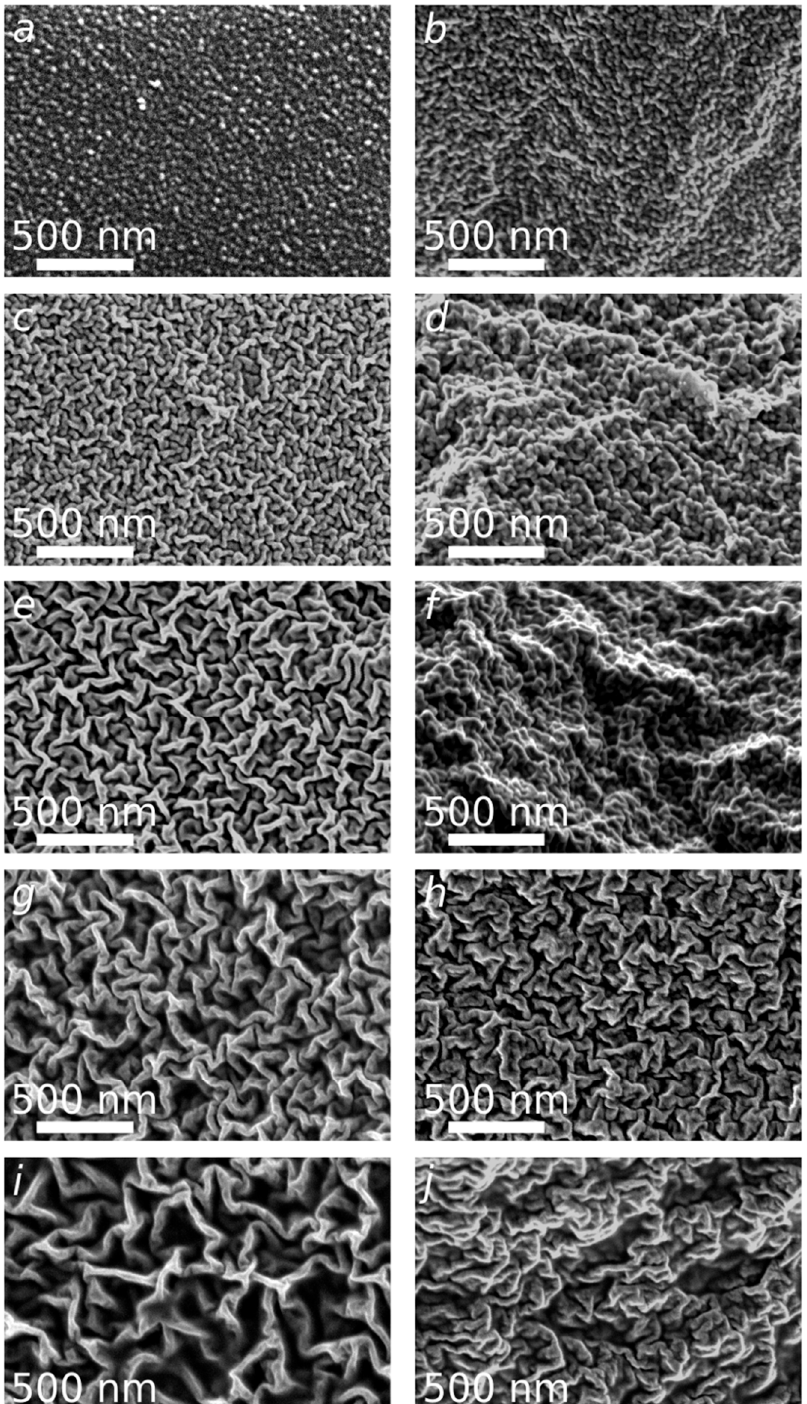
Figure 3. SEM micrographs of the reference CS film (CS/DES-0) ( a , b ) and films with different NADES contents: 50 wt% ( c , d ), 67 wt% ( e , f ), 75 wt% ( g , h ) and 82 wt% ( i , j ). The surface ( a , c , e , g , i ) and the cross-sectional morphology ( b , d , f , h , j ) of films.